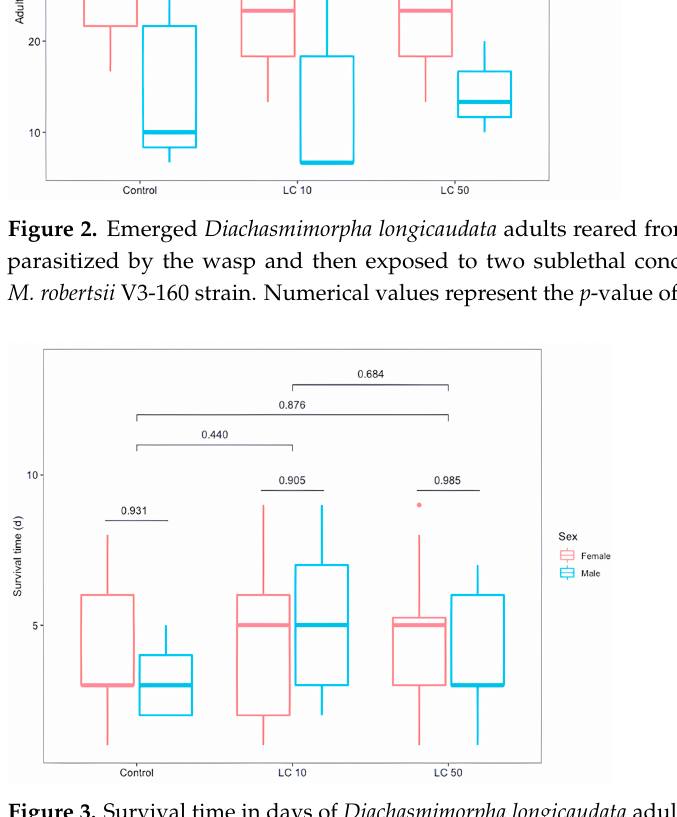
Figure 3. Survival time in days of Diachasmimorpha longicaudata adults reared from Anastrepha lu ‐ dens larvae first parasitized by the wasp and then exposed to two sublethal concentrations (LC 10 and LC 50 ) of M. robertsii V3 ‐ 160 strain. Numerical values represent the p ‐ value of paired